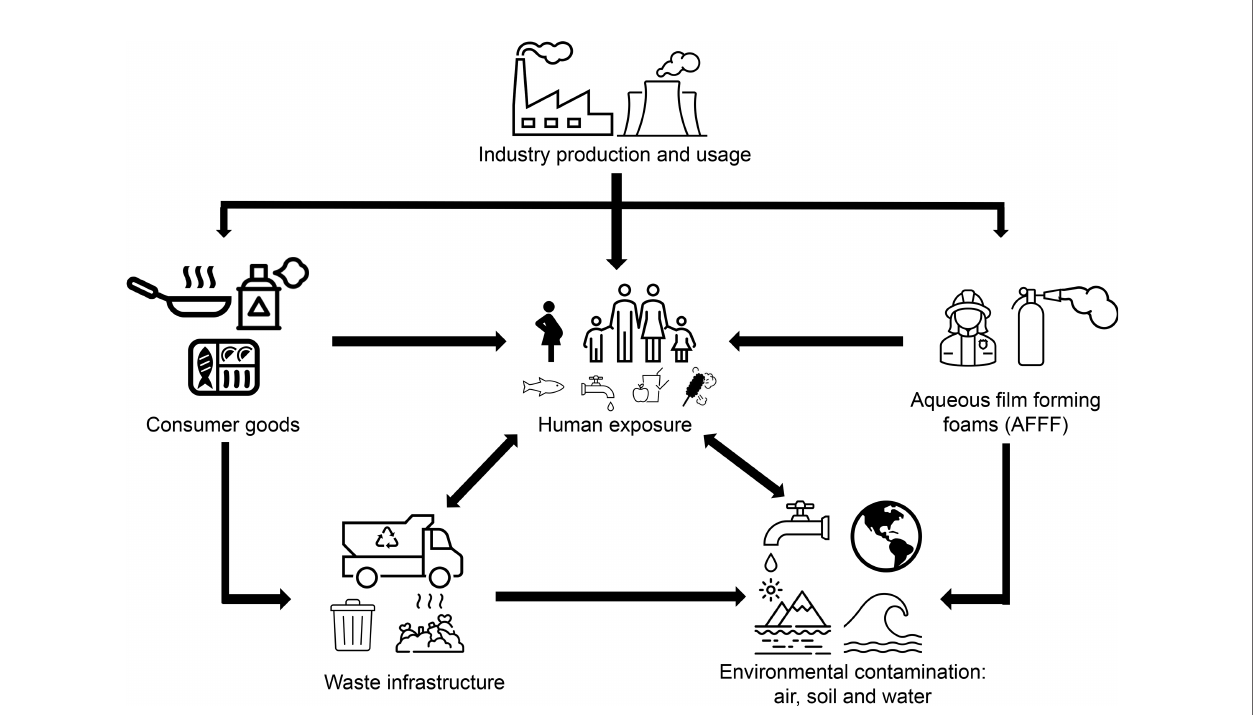
FIGURE 2 | Schematic diagram illustrating the routes of human PFAS exposure. Following production, PFAS are used in consumer products such as food packaging, cookware, water repellent clothing and non-stick fry pans. PFAS are also a main component in fi re fi ghting foam, which can leach into the environment, or are otherwise disposed of as industrial waste. Human exposure may occur through use of consumer products or from contaminated water supplies. Accordingly, environmental exposure can occur as a result of waste products contaminating waterways and soil through leaching of fi re fi ghting foam and waste from industry and